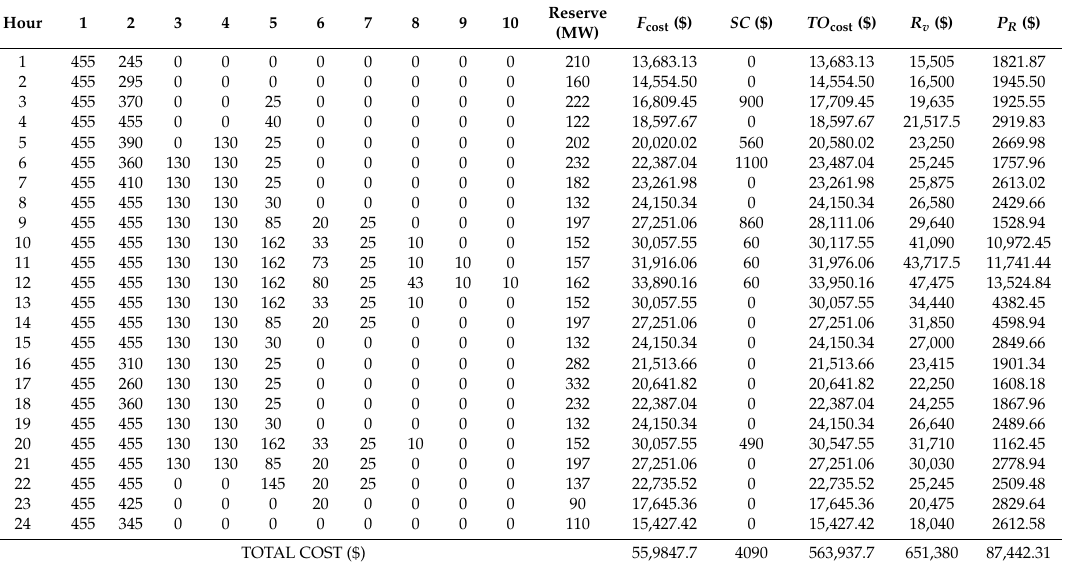
Table 6. Output data for base case using Traditional Unit Commitment (TUC).